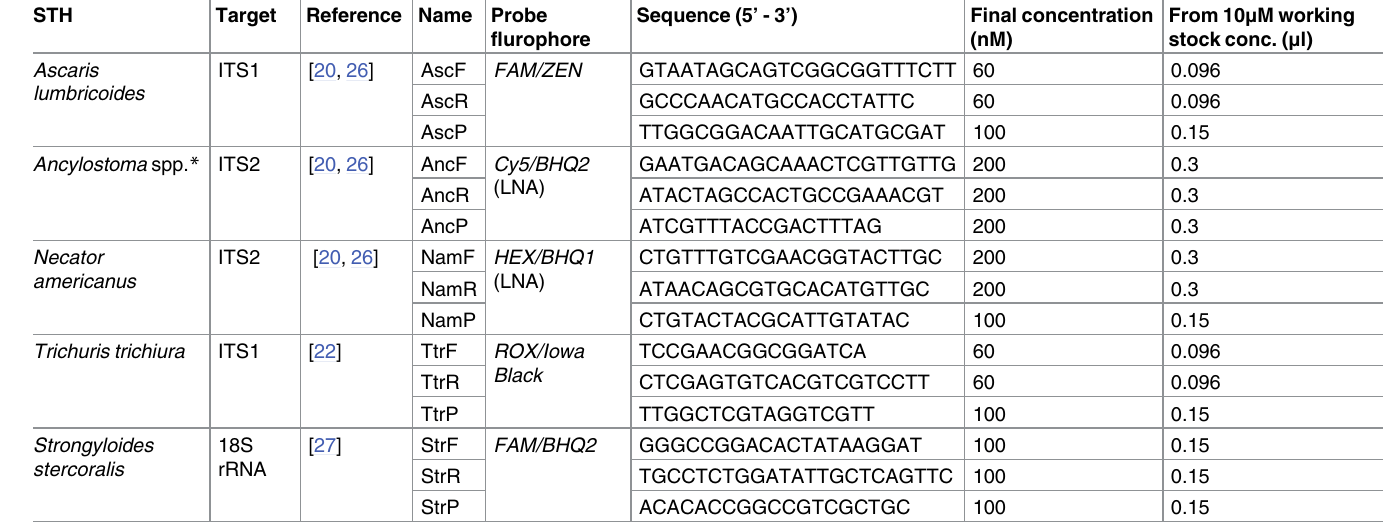
Table 1. Primers and probes used in the multiplex